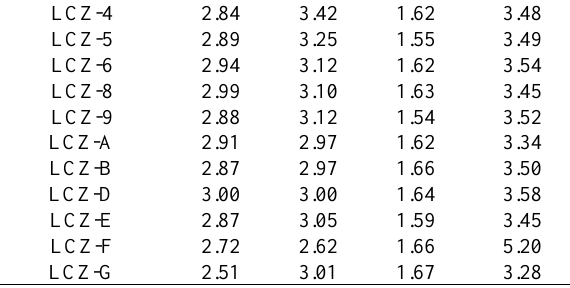
Table 2 . Standard deviation of the mean LST variations per LCZ and season from 2012 to 2019 using MODIS data when analysing typical days per season.